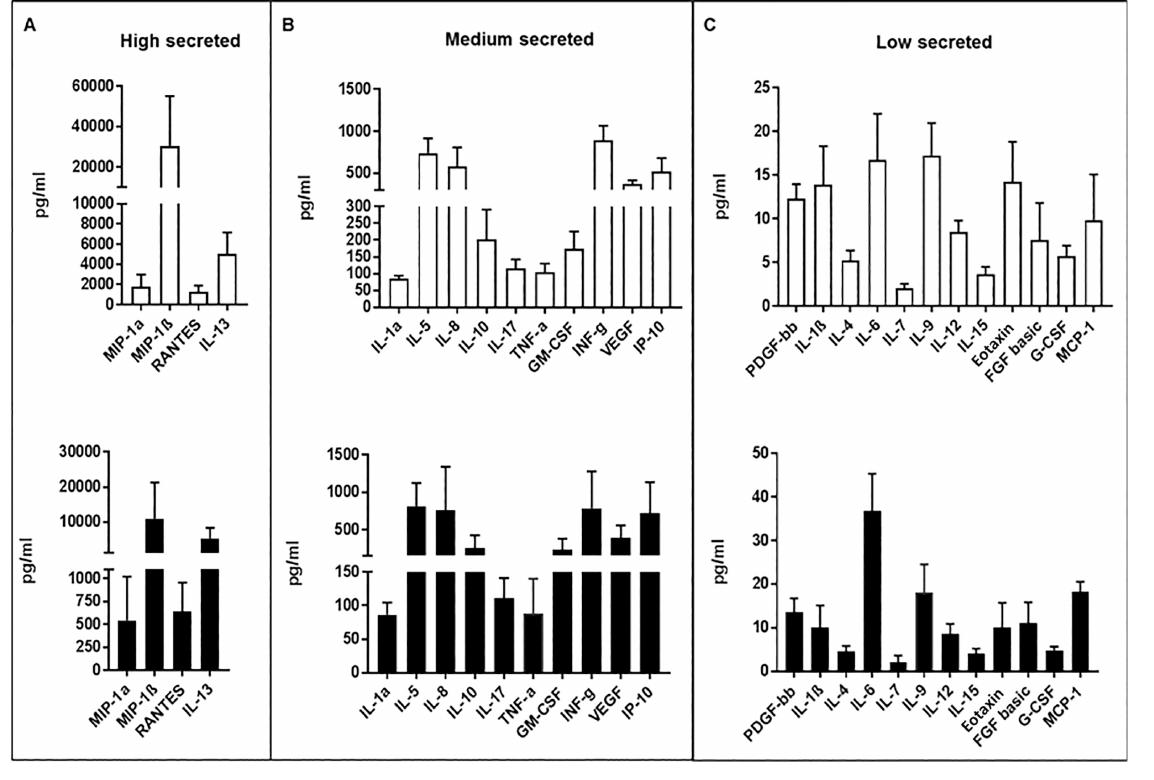
Figure 2. Secretome of mature CIK cells. Secretion of 27 cytokines and cell soluble factors were measured by Bio-Plex cytokine assay on CIK cell supernatants at d 21 of culture. Histograms (white for patients, black for healthy donors) represent mean values ± standard devi- ation (pg/mL) of secreted